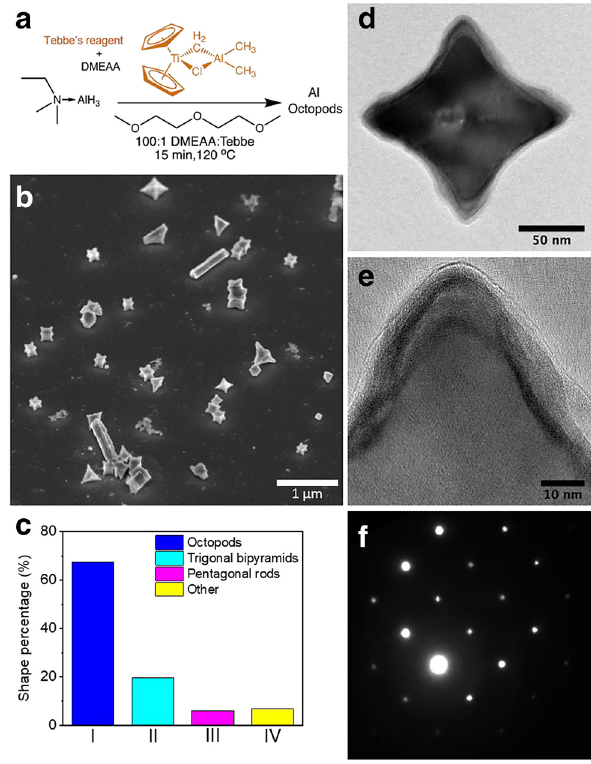
Figure 8: Preparation of aluminum octopod and high-resolution TEM. (a) Schematic illustration of the preparation process of aluminum octopod. (b) Tilted (45 ° ) SEM of the morphology in aluminum octopods solution. (c) Statistical of the percentage of different shapes of aluminum nanoparticles. (d) High-resolution TEM of aluminum octopod. (e) Zoom-in inspection of the corner of Al octopods. (f) SAED of the selected aluminum octopods